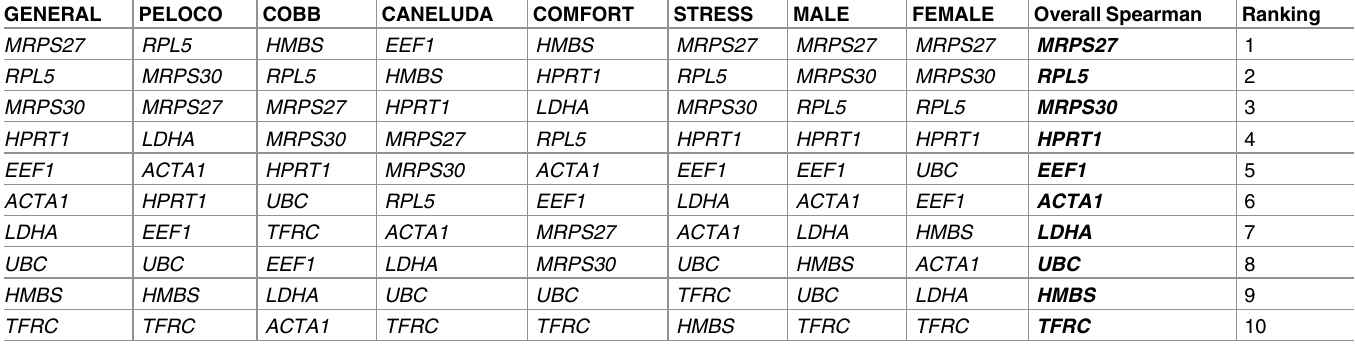
Table 10. Overall ranking of referencegenes in chickens obtained by different tools (SLqPCR, NormFinder, Bestkeeper and Comparative Ct) and ranked by RankAggreg package according to each treatment (genetic groups, environment and sex).